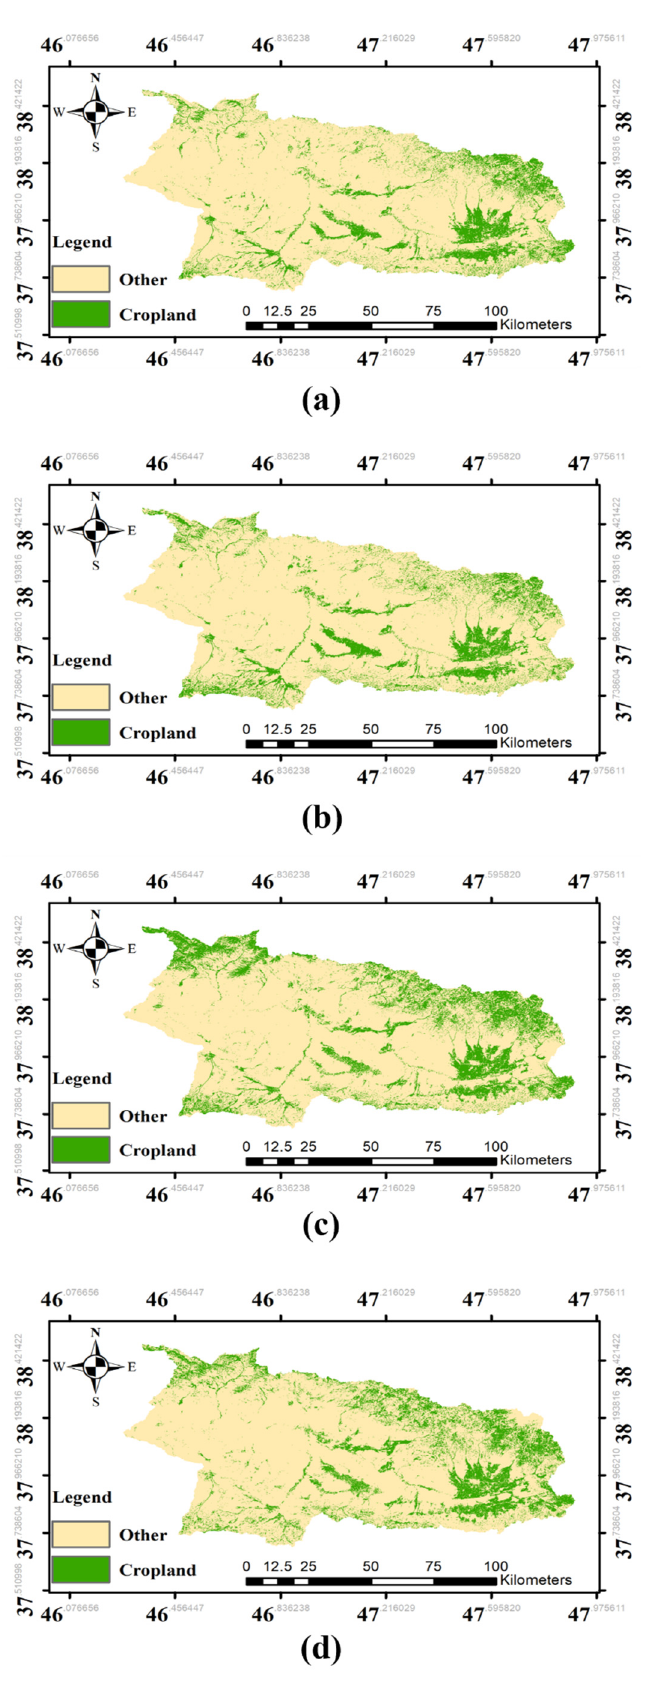
Figure 12. Land use maps for the AC watershed for ( a ) 1990, ( b ) 2000, ( c ) 2010, and ( d ) 2020.